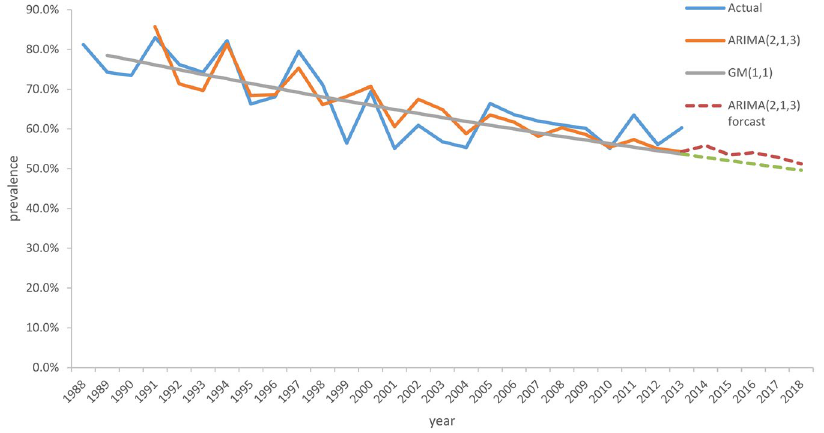
Figure 6. Two models’ fitting and prediction curves and the actual data